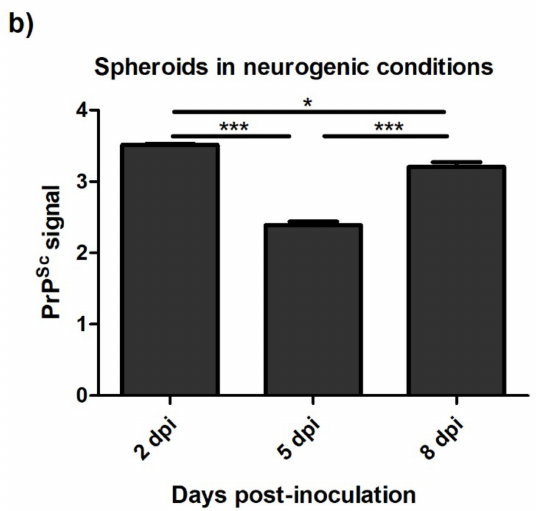
Figure 7. PrP Sc levels detected by ELISA in spheroids in growth ( a ) and neurogenic ( b ) conditions 2, 5, and 8 days after prion infection. Data are shown as mean values ± SEM. * p < 0.05; *** p < 0.001.